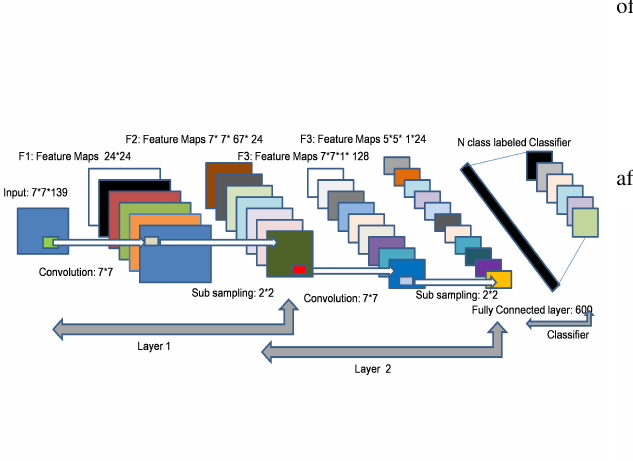
Figure 2: Architecture of 2D Deep Convolutional Neural Net- work on hyperspectral imagery